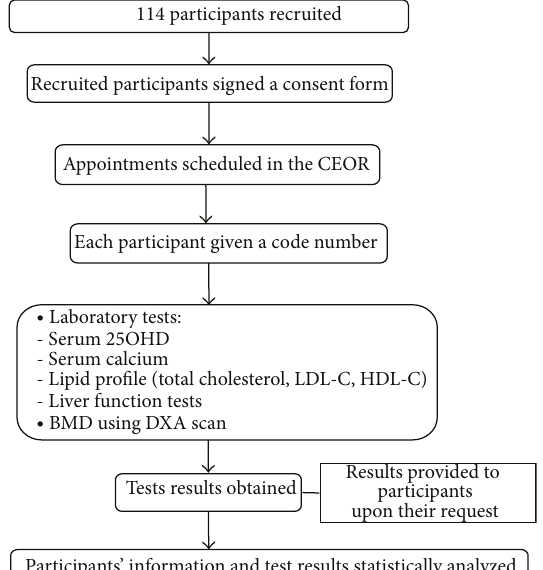
Figur e 2: Study process. CEOR: Center of Excellence for Osteo- porosis Research; 25OHD: 25-hydroxyvitamin D; LDL-C: Low density lipoprotein cholesterol; HDL-C: High density lipoprotein cholesterol; BMD: Bone mineral density; DXA: Dual-energy X-ray